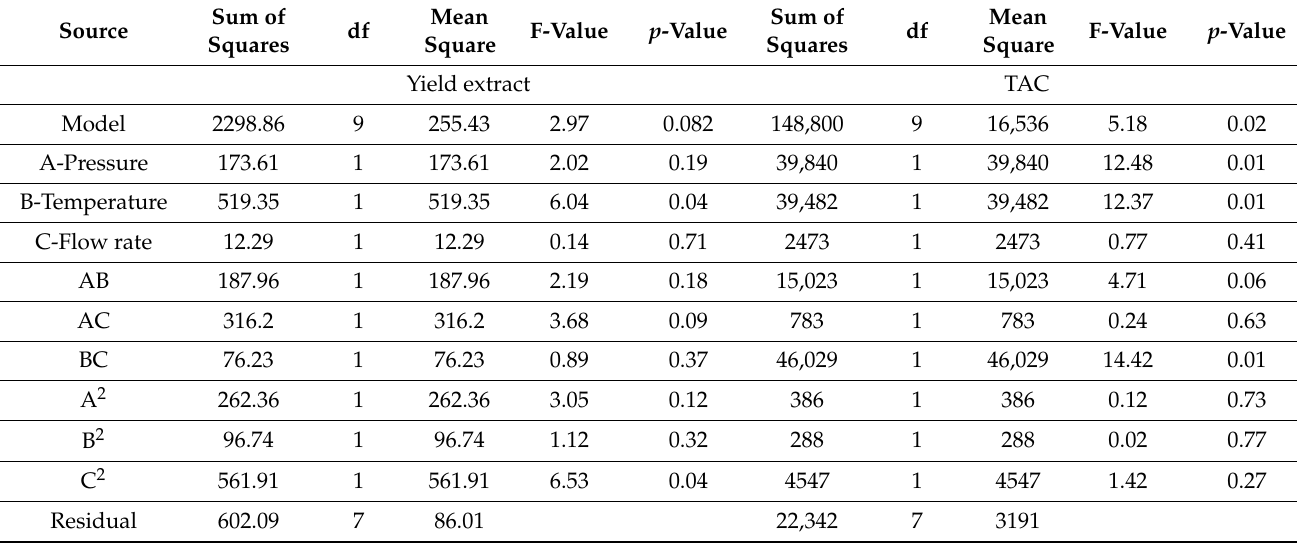
Table 3. ANOVA table for the response of yield for